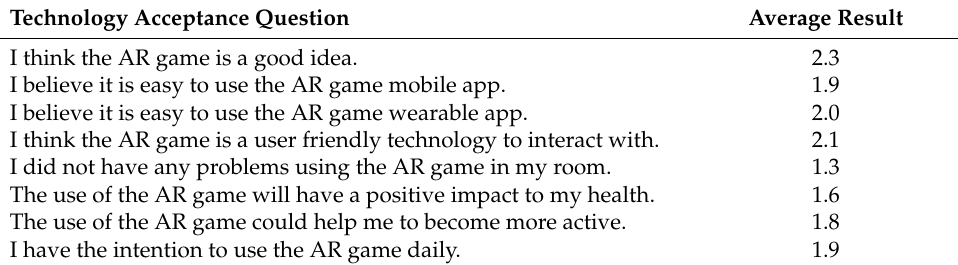
Table 7. Technology Acceptance questionnaire